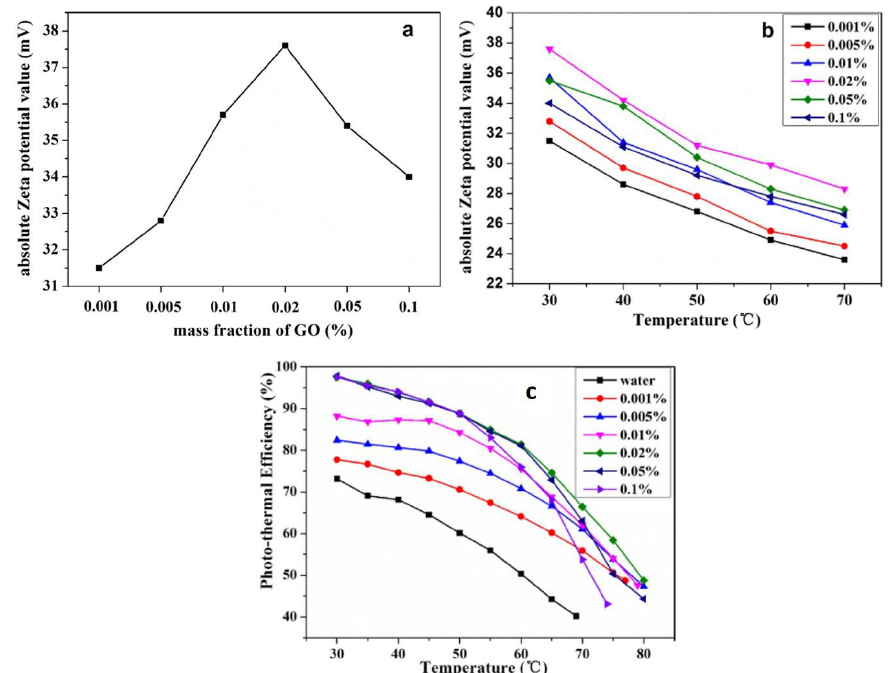
Figure 18. ( a , b ) Zeta potential and ( c ) photo-thermal energy conversion of GO/water nanofluid [66]; 2017, Elsevier.